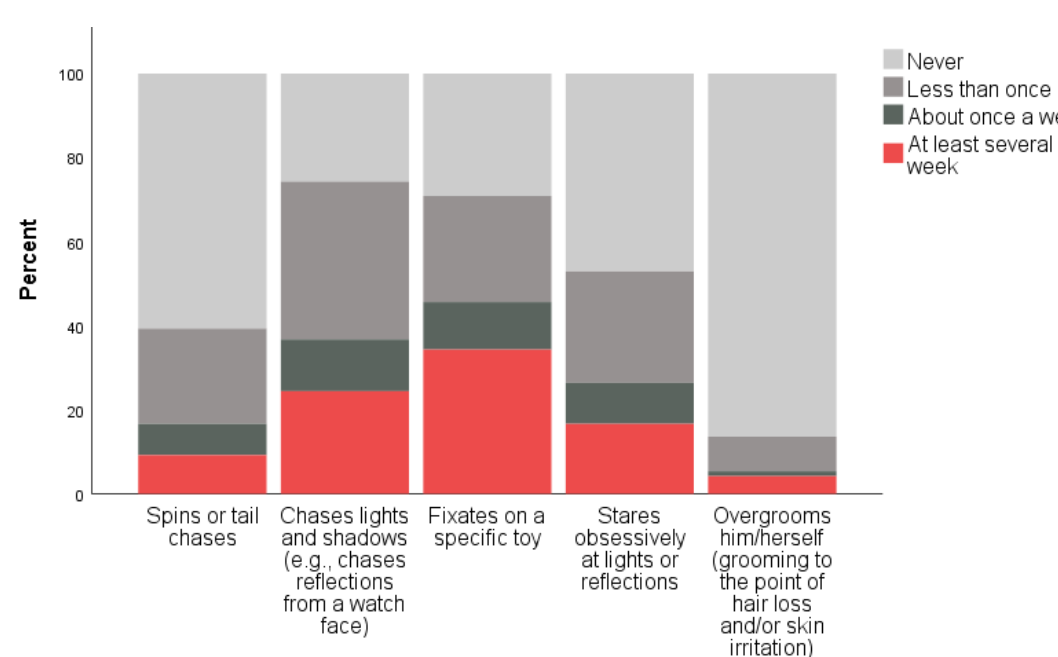
Figure 1. Cat guardian responses to questions related to frequency of exaggerated or abnormal repetitive behaviors in their cats.